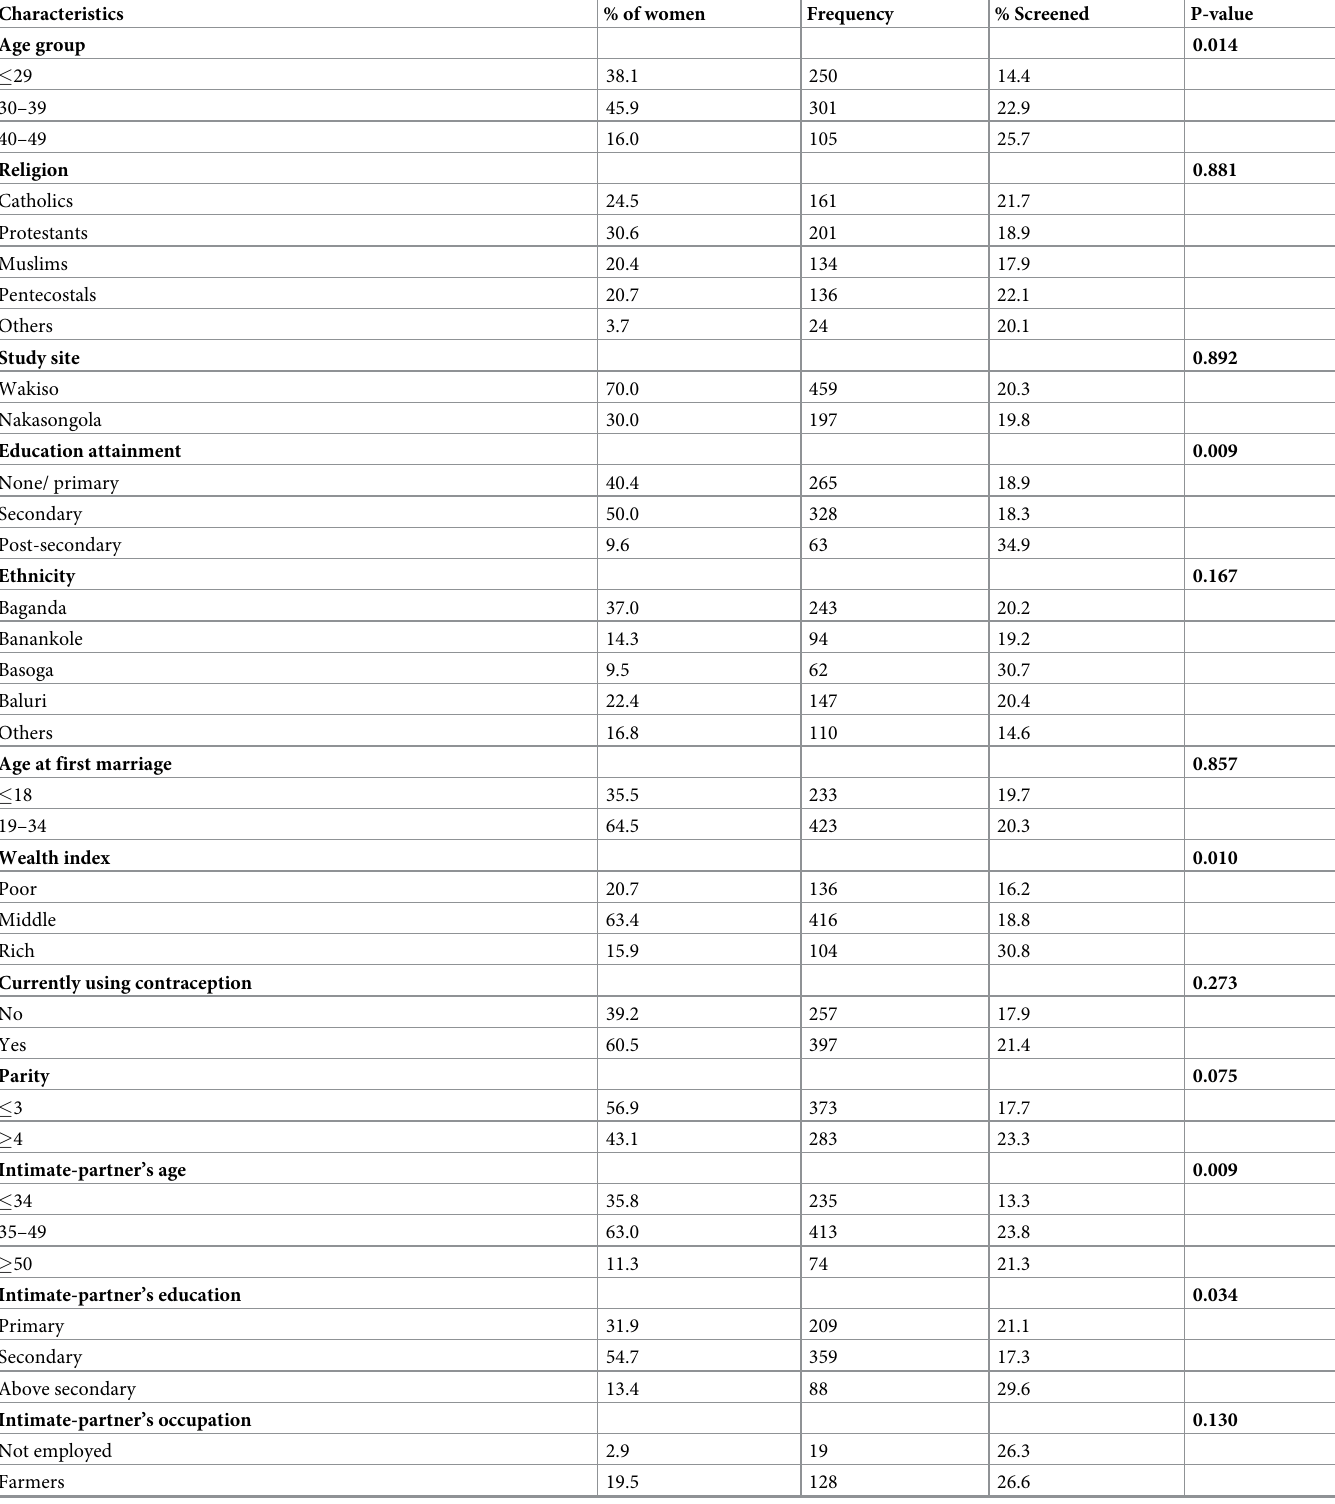
Table 1. Distribution of study participants by demographics, socio-economic factors, intimate-partner factors and cervical cancer screening status (N = 656).